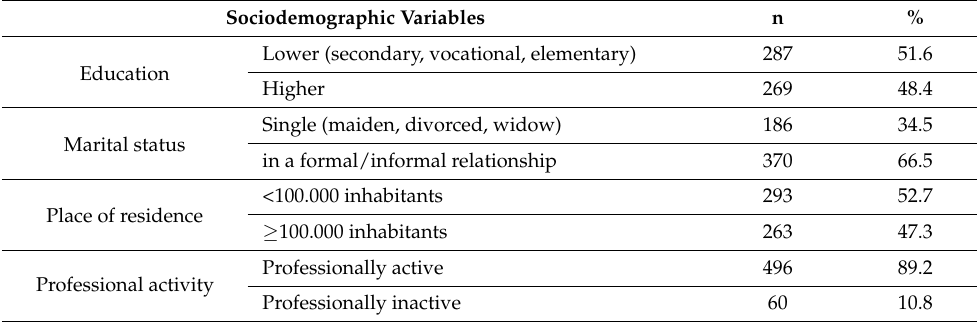
Table 1. General sociodemographic characteristics of the study group (n =